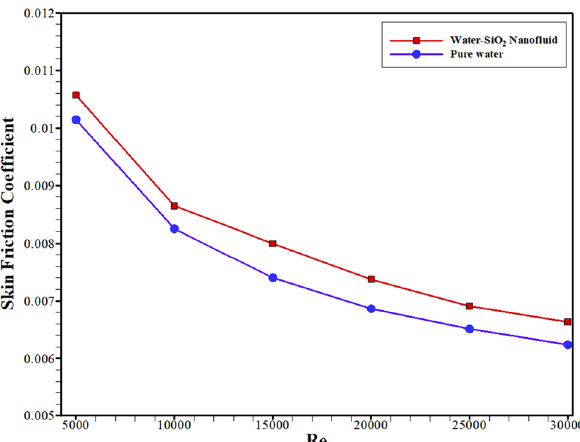
Figure 5: The skin friction coe ffi cient, Reynolds number variation for various volume fractions of metal oxide nanoparticles, and ϕ of water/SiO 2 nano fl uid with dp = 20